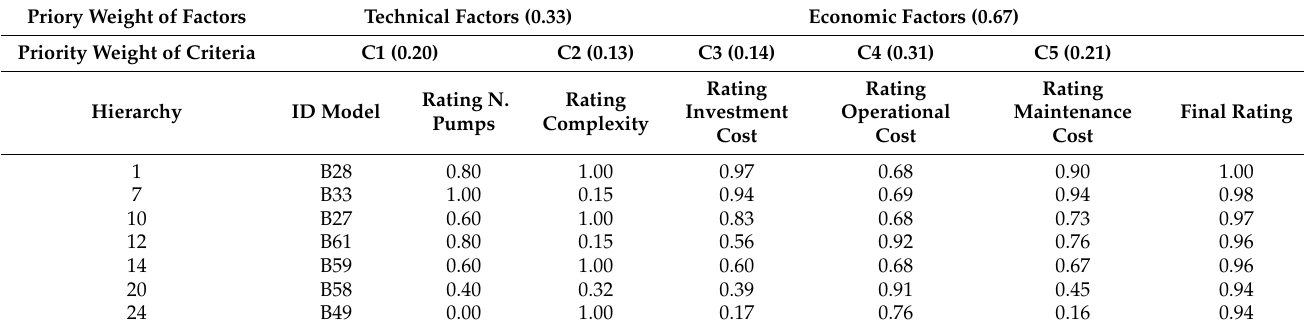
Table 15. Rating of the criteria and overall rating for each alternative